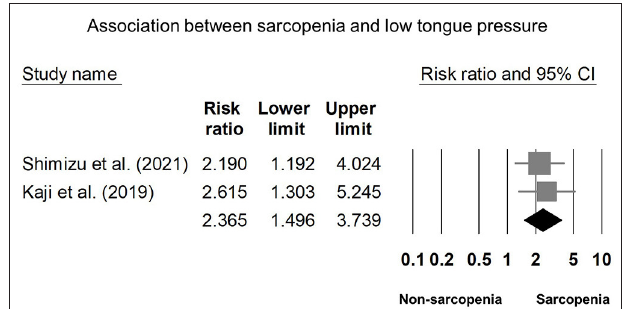
FIGURE 5 | Funnel plot of the association between sarcopenia and low tongue